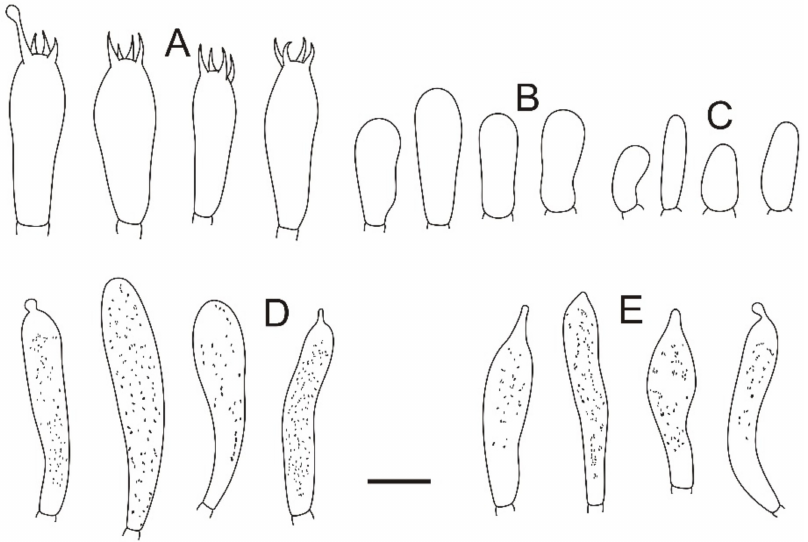
Figure 24. Microscopic features of Russula yanshanensis (BJTC C561). ( A ) Basidia. ( B ) Basidiola. ( C ) Marginal cells. ( D ) Hymenial cystidia on lamellae sides. ( E ) Hymenial cystidia on lamellae edges. Scale bar: 10 µ m.